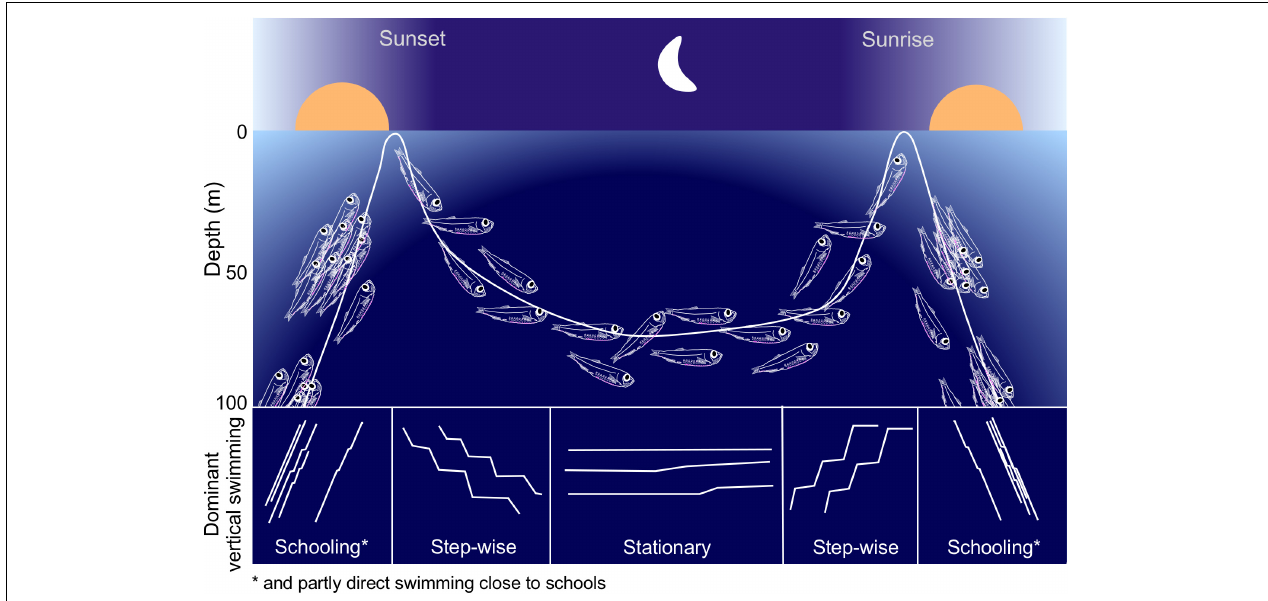
FIGURE 9 | Schematic showing a typical night time distribution and behavior of M. muelleri juveniles in Masfjorden. The lower part of the figure indicates the dominant vertical swimming patterns during different parts of the night.